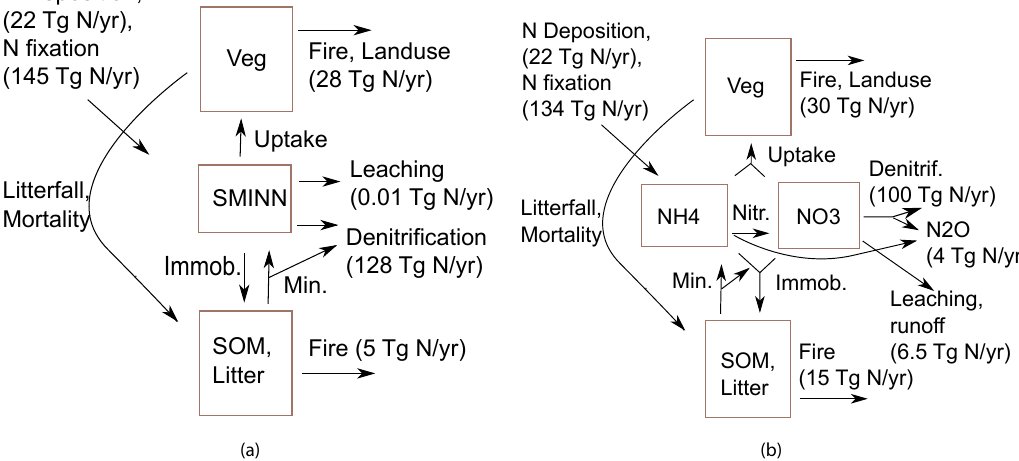
Fig. 12. Schematics of N cycle in base and updated versions of CLM4; numbers refer to the global mean slow N cycle source and sink terms for an 1850 control scenario.